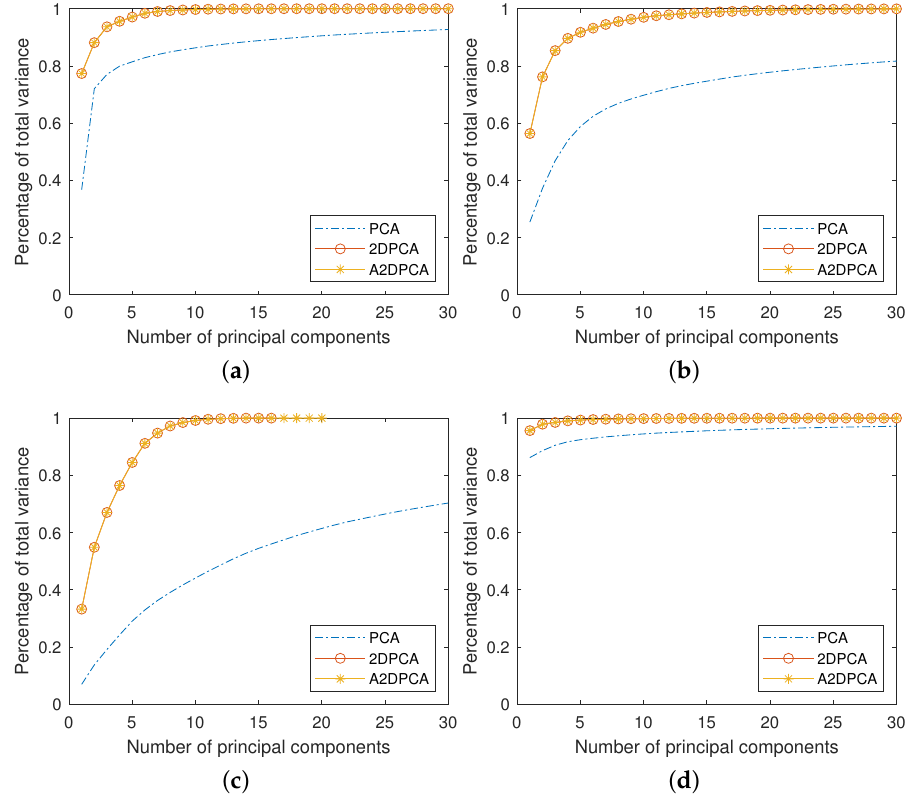
Figure 5. The percentages of total variance explained by the first thirty principal components. ( a ) Extended Yale B face database. ( b ) AR face database. ( c ) Binary Alphadigits database. ( d ) PolyU 3D palmprint